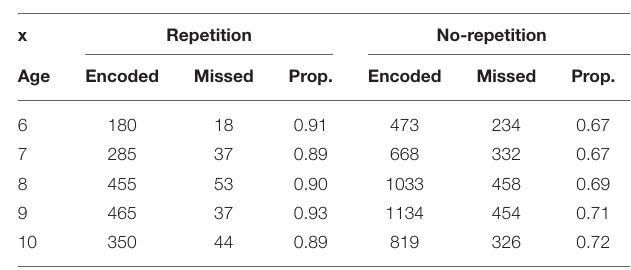
TABLE 2 | Proportion of items encoded conditional on the similarity to the previous